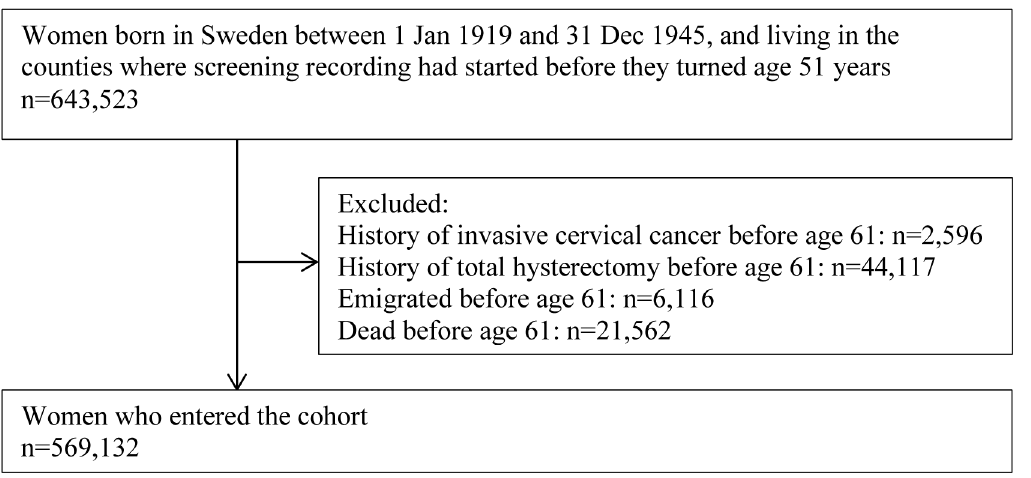
Fig 1. Flow chart for the study